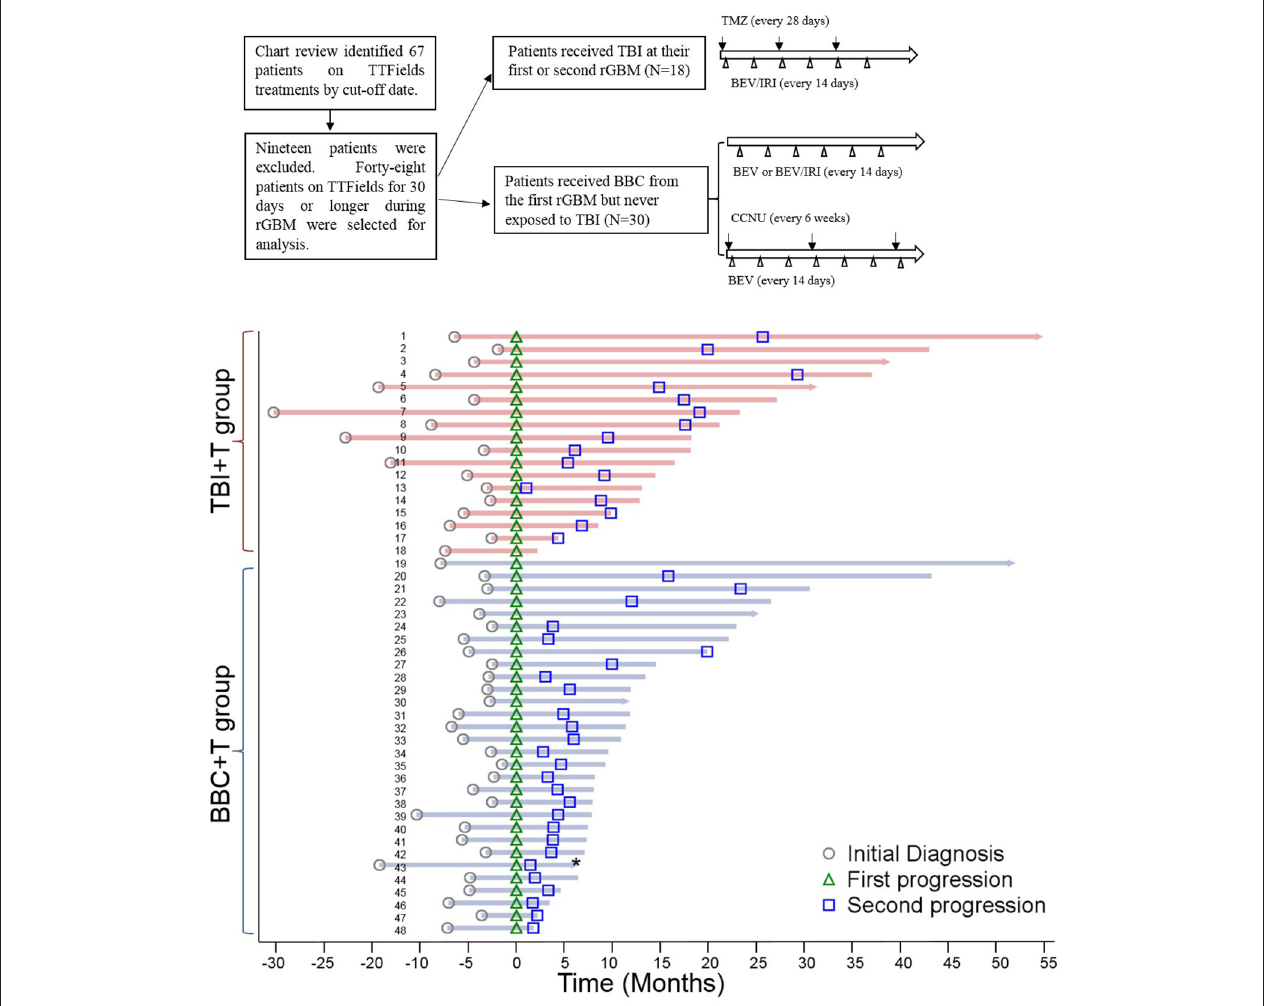
FIGURE 1 | Data review flowchart and swimmer plot of patients who received TTFields for 30 days and longer. Data review flowchart showed the data selection process and treatments with different salvage chemotherapies in two subgroups. Patient’s IDs are listed on each line within the swimmer plot. All patients are aligned according to the date of first disease progression (green triangle), and the second GBM progression dates are all marked (blue square). The horizontal bar with an arrow at the right end indicates subjects who were still alive as of 3/31/2018 while the blunt end bar indicates subjects who passed away. Survival status for patient number 43 in BBC + T group was unknown